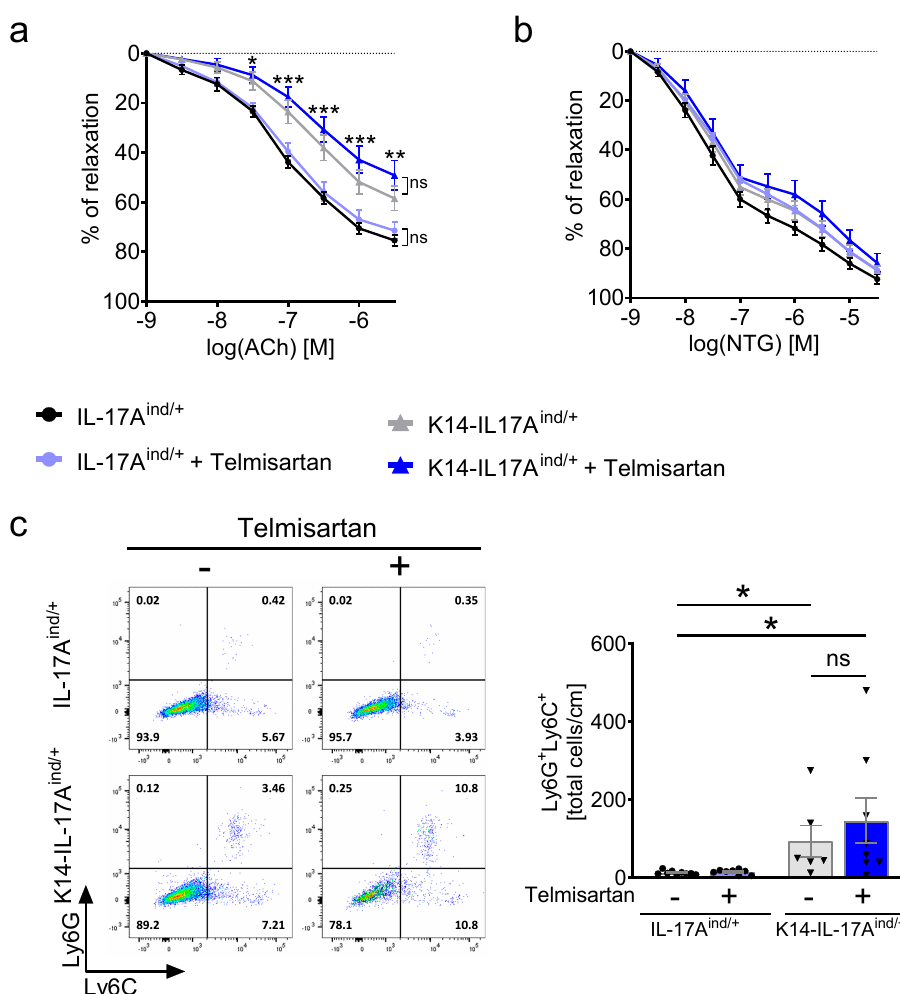
Figure 3. Telmisartan treatment does not attenuate vascular dysfunction and vascular inflammation in mice with severe psoriasis. ( a ) Isometric tension studies of aortic rings in response to Acetylcholine (Ach) for endothelium-dependent vascular relaxation. Two-way analysis of variance test and Bonferroni post hoc test, n = 6–9. Asterisks indicate significances between K14-IL-17A ind /+ and IL-17A ind /+ control mice. ( b ) Isometric tension studies of aortic rings in response to nitroglycerine (NTG) for endothelium independent vascular relaxation. Two-way analysis of variance test and Bonferroni post hoc test, n = 6–9. ( c ) Flow-cytometric analysis of aortas. Representative plots are shown for each group. The total cell number of Ly6G + Ly6C + neutrophils per 1 cm of aorta is presented. Cells were pre-gated on living CD45.2 + and CD11b + cells, n = 6–9. Kruskal–Wallis one-way ANOVA with Dunn multiple comparisons tests. IL-17A ind /+ mice are presented with black circles and K14-IL-17A ind /+ mice are presented in black triangles. The p-values of ≤ 0.001, ≤ 0.01, and ≤ 0.05 were considered statistically significant and marked by three, two, and one asterisks, respectively, ns = not significant. All data are presented as mean ± SEM.